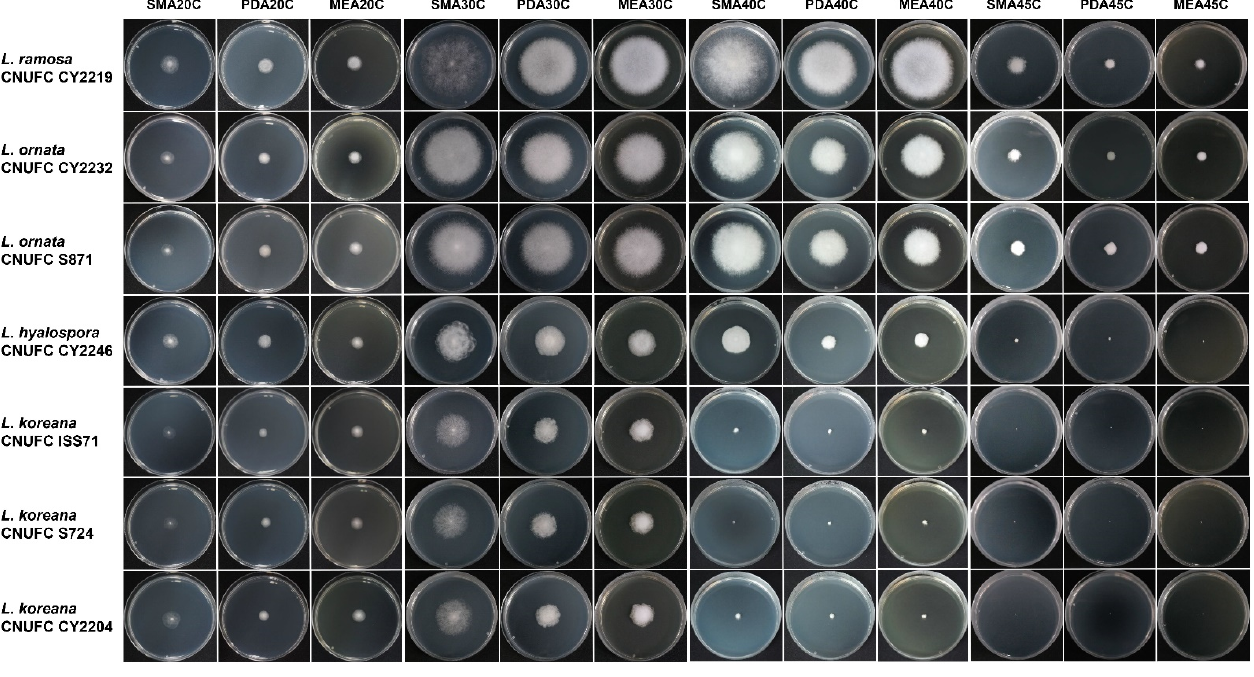
Figure 4. Radial growth determination of Lichtheimia species at different temperatures of 20, 30, 40 and 45 °C on SMA, PDA and MEA. and 45 ◦ C on SMA, PDA and